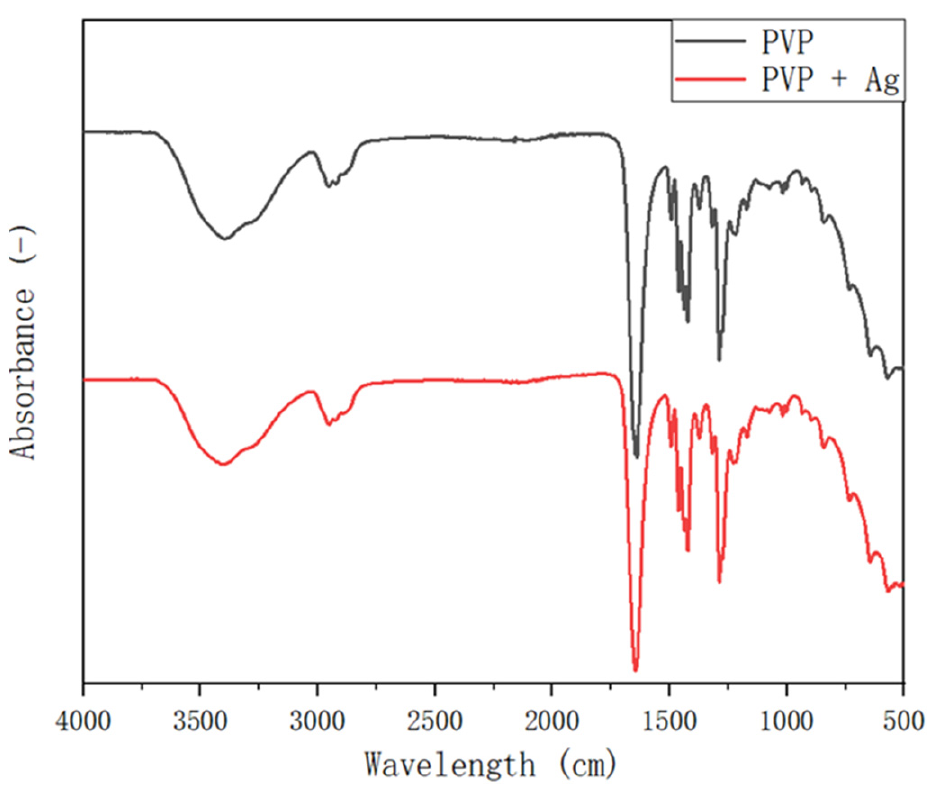
Figure 9. FT-IR spectrum of the pure PVP fibers and of the PVP/Ag NP composite fibers electrospun at 5 MPa and applied voltage of 15 kV. Table 1. Typical bands in infrared spectra of PVP.